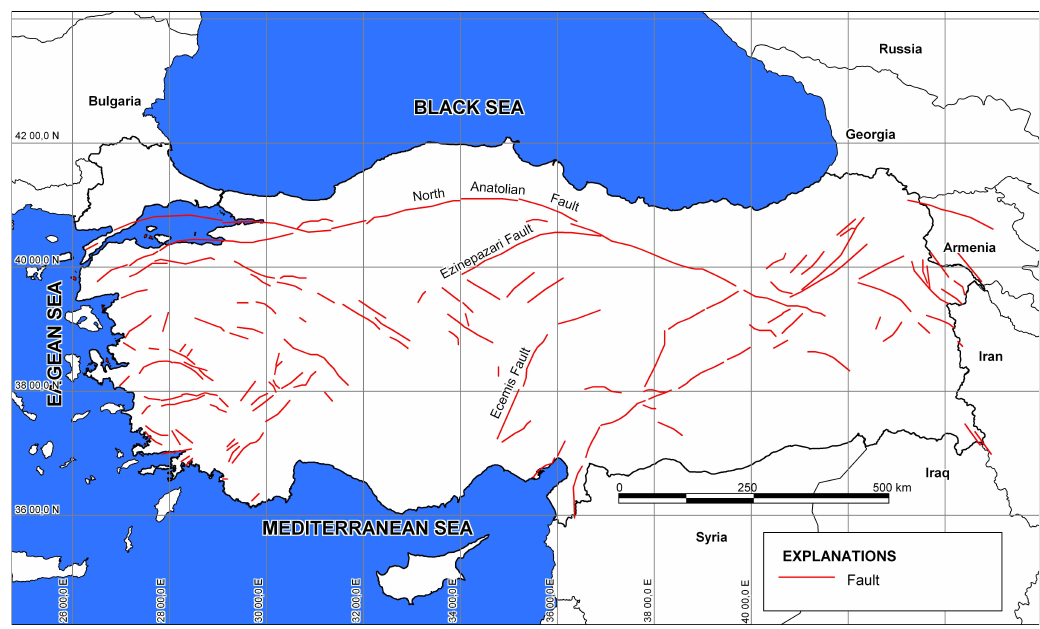
Fig. 2. Major structural elements of seismo-tectonic models of Turkey.